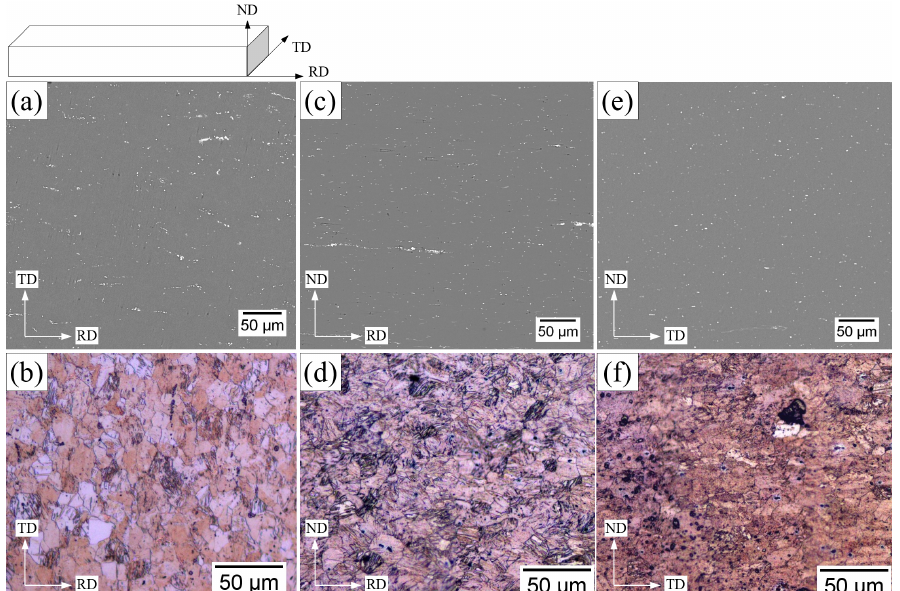
Figure 2. Schematic directions in the rolled plate and SEM/BSE micrographs ( a , c , e ) and LOM micrographs ( b , d , f ) of the rolled specimen.